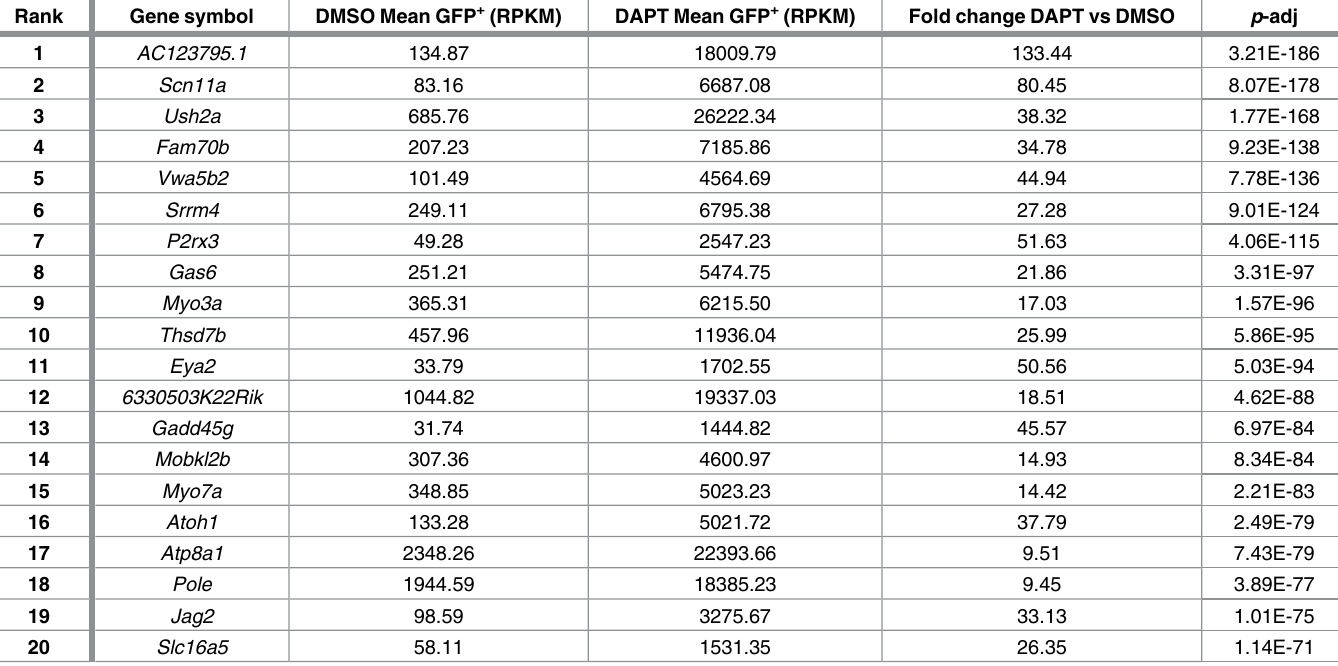
Table 10. Top 20 up-regulated genes after DAPT treatment in P0 Lfng-GFP + cells.